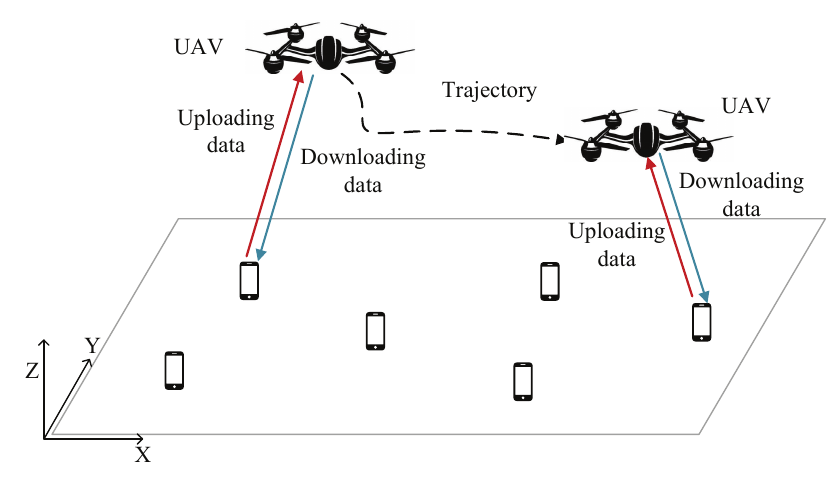
Figure 1. UAV-enabled MEC